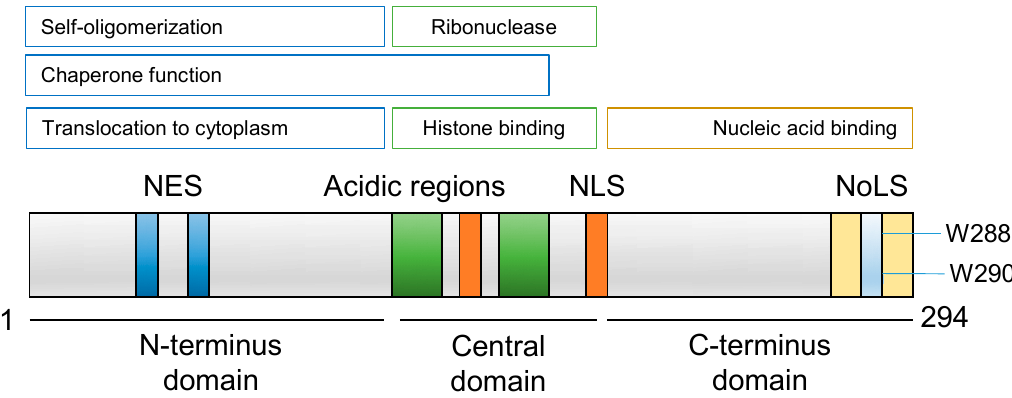
Figure 1. Nucleophosmin (NPM1) protein structure and functions. The nuclear export system (NES) (blue) located in the N-terminus domain promotes the translocation of NPM1 from the nucleus to the cytoplasm. The central domain contains the acidic regions (green) and a nuclear localization signal (NLS) (orange), and mediates histone binding and the ribonuclease activity. The C-terminus domain has a highly conserved aromatic region and the nucleolar localization signal (NoLS) (yellow) which contains Trp-288 and Trp-290.